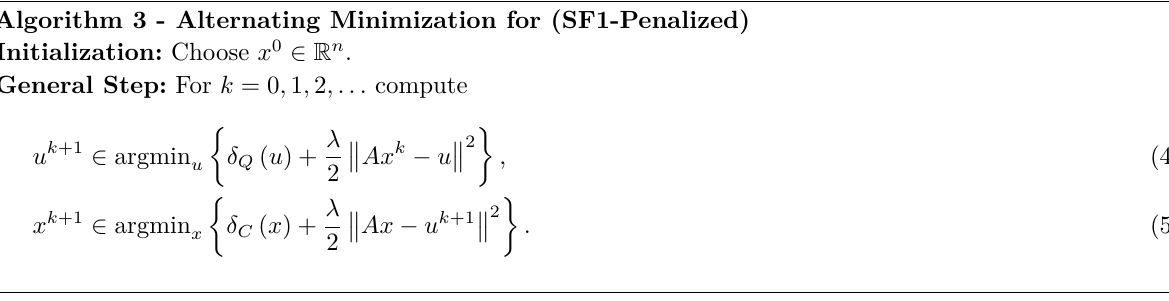
Algorithm 3 - Alternating Minimization for (SF1-Penalized)